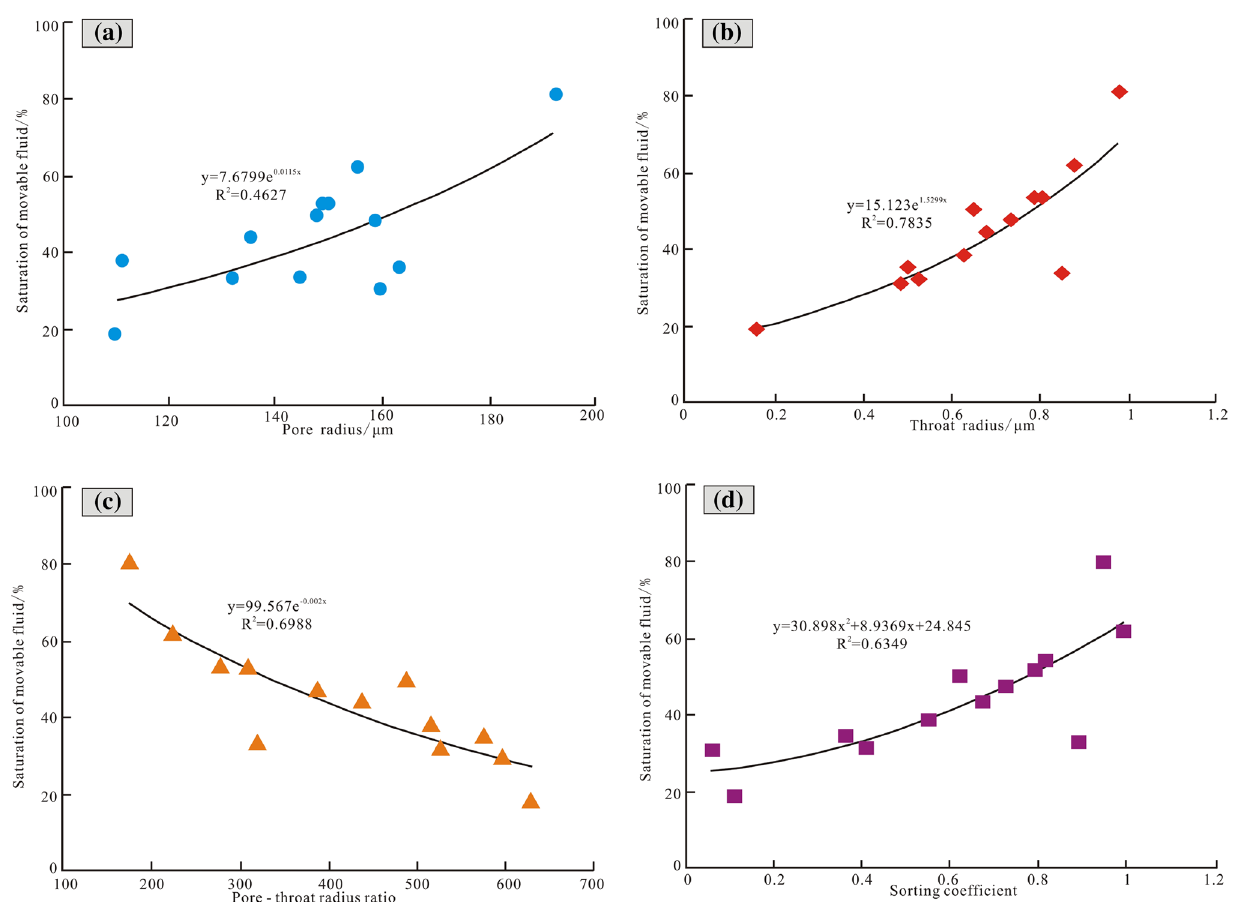
Fig. 6 Relationship between microscopic pore–throat structure parameters and movable fluid saturation in Chang 8